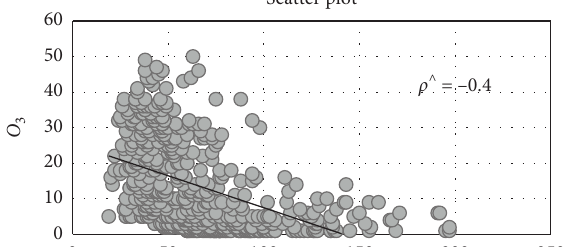
Figure 1: The scatter plot of O